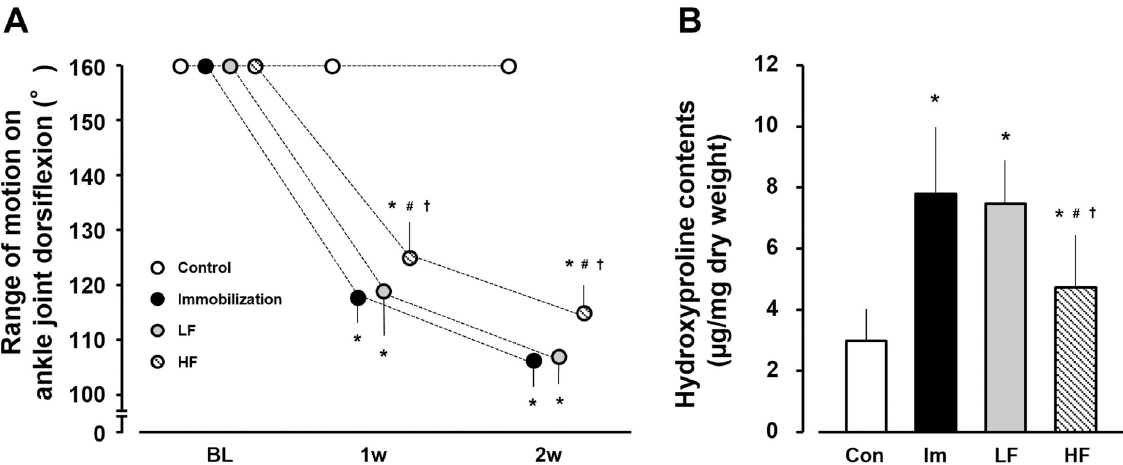
Fig 6. Range of motion of the ankle joint on dorsiflexion (A) and hydroxyproline content (B) in gastrocnemius muscle. Open circles and bars, control group (control). Black circles and bars, immobilization group (Im). Gray circles and bars, LF group. Hatched circles and bars, HF group. Data are presented as mean ± standard deviation. � Significant difference (p < 0.05) compared to the control group #Significant difference (p < 0.05) compared to the immobilization group. †Significant difference (p < 0.05) compared to the LF group. LF, low-frequency; HF,